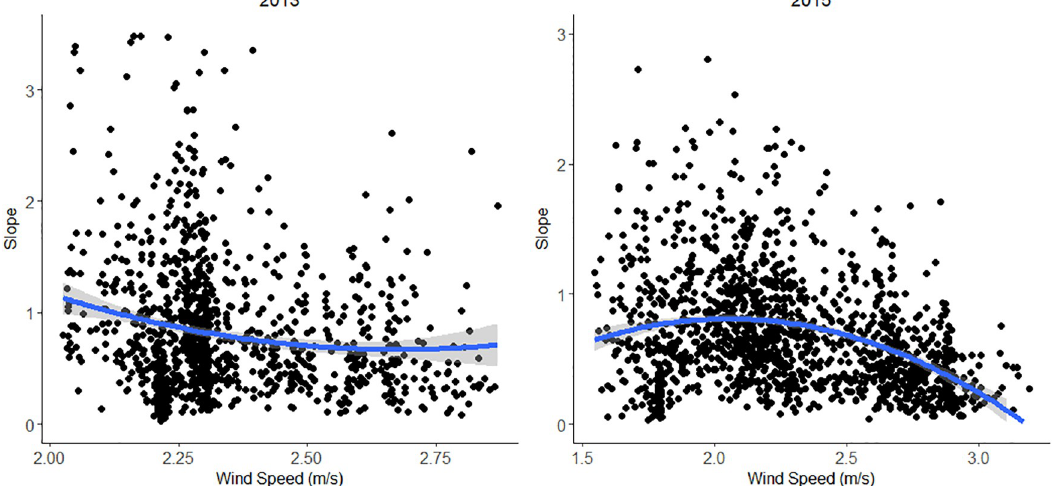
Fig 8. Slope of water vapor and the wind speed above the field show significant quadratic relationships for 2013 and 2015. 2013: Slope = 11.73–8.41 � WS+1.60 � WS 2 , r 2 = 0.03, p < 0.001, n = 1130; 2015:Slope = -2.20+2.78 � WS-0.67 � WS 2 , r 2 = 0.05, p < 0.001, n =